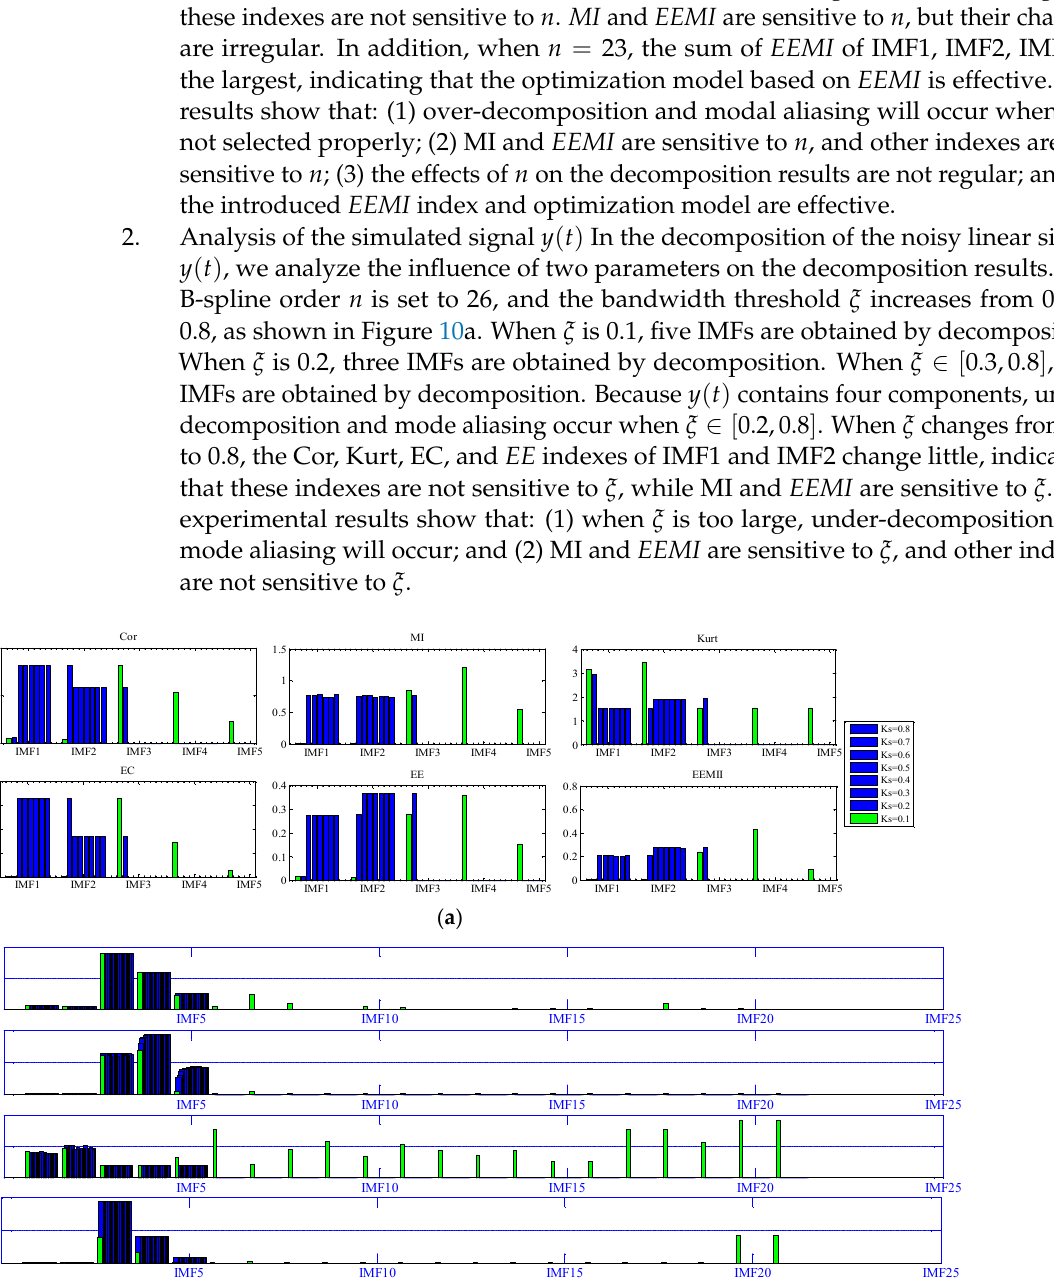
Figure 10. The relationship between the indexes of the IMF and the parameters ( a ) bandwidth threshold ξ , and ( b ) B-spline order n for simulated signal y ( t ) . Next, the bandwidth threshold ξ is set to 0.1, and the B-spline order n is increased from 6 to 30, as shown in Figure 10b. When n = 6, 21 IMFs are obtained by decomposition, indicating that n is not selected properly and over-decomposition occurs. When n ∈ [ 7, 30 ] , five IMFs are obtained. When =6 n , the Kurt, EC, and EE indexes of IMF19 and IMF21 are relatively large. If these indexes are used as the objective function, the param- eters obtained will lead to over-decomposition. When =6 n , the Cor and MI of multiple IMFs are also larger, and the EEMI indexes are mainly concentrated in IMF3, IMF4, and IMF5, indicating that these three modes are effective modes. The results show that: (1) over-decomposition and mode aliasing will occur when n is not selected properly; and (2) the EEMI index mainly focuses on the effective mode and is sensitive to n , so EEMI is effective. 4.2.3. Validation of the Proposed Method The above results show that the effects of and n on the results are cross-coupled, and the effects of the two parameters on the results are irregular, and it is particularly difficult to determine the appropriate parameter group. Therefore, we determine the op- timal parameters of TVF-EMD by GOA and IGOA, and analyze the signals